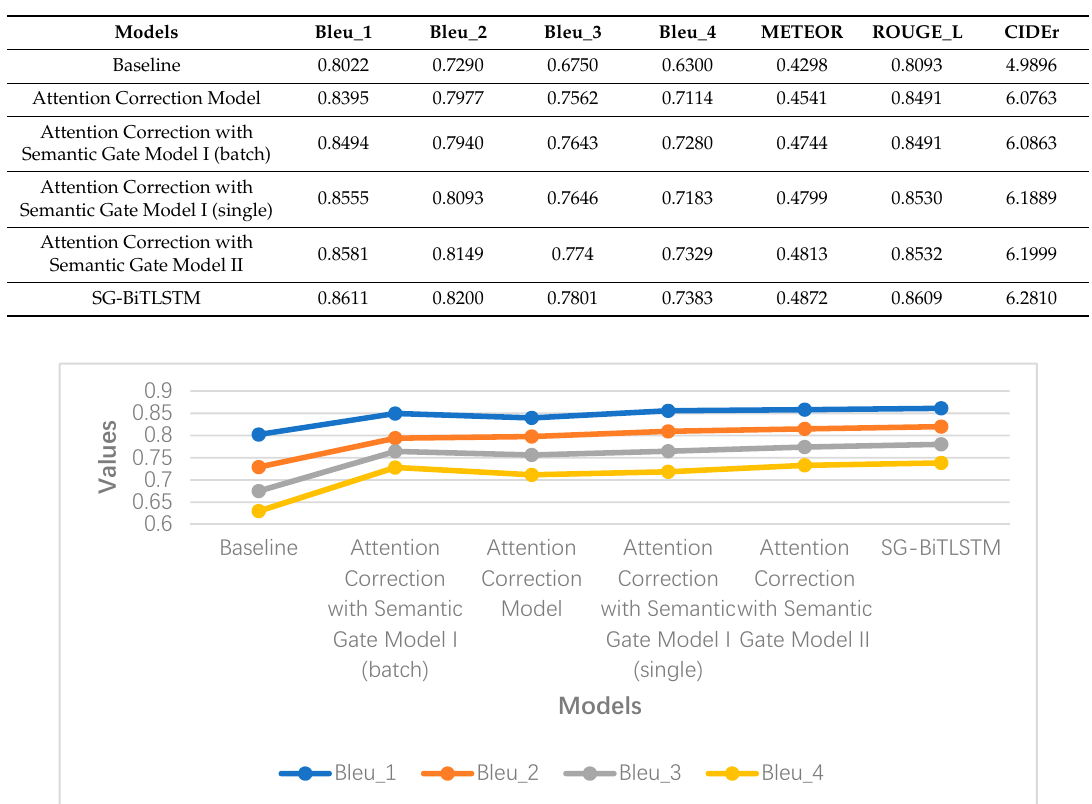
Figure 13. Bleu values of the models.